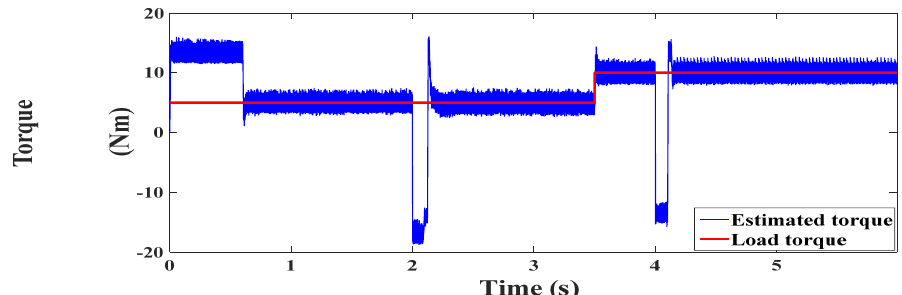
Figure 8. Rotor speed profile under PTC approach (RPM).